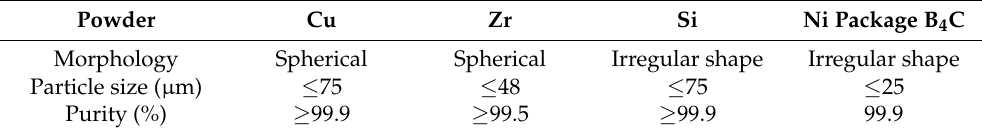
Table 1. Parameters of cladding